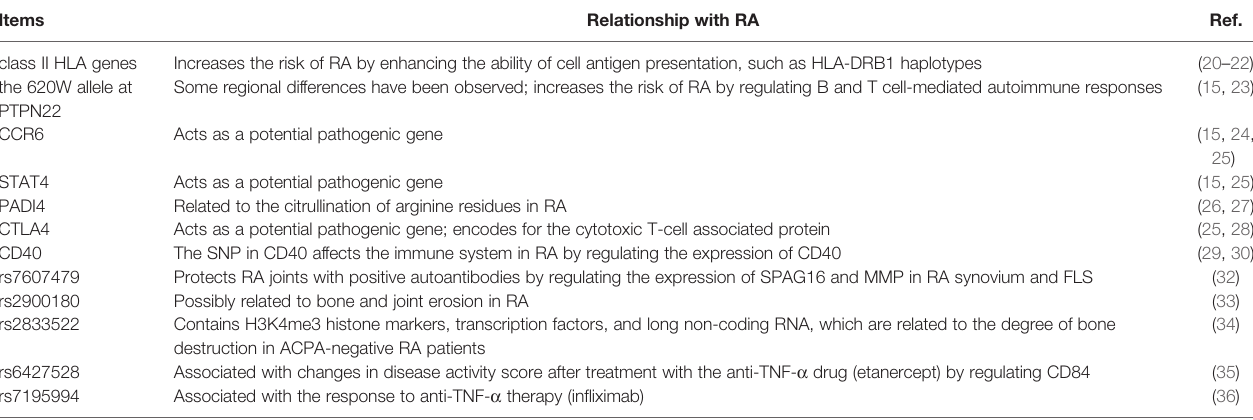
TABLE 1 | Main molecular variation underlying the RA risk variability. Items